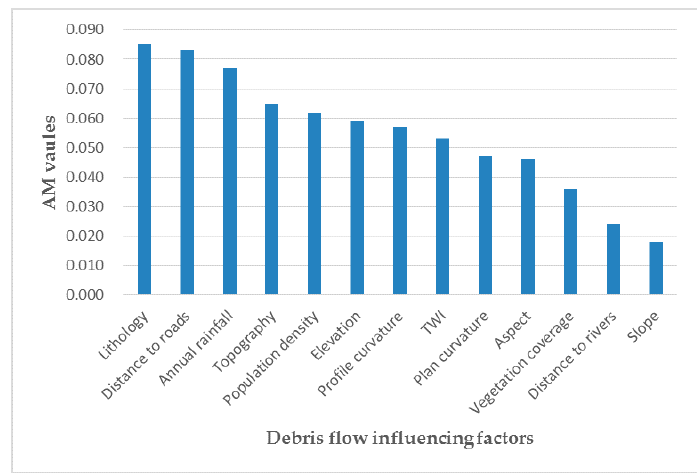
Figure 13. Average merit (AM) values of influencing factors using the gain ratio (GR) method.